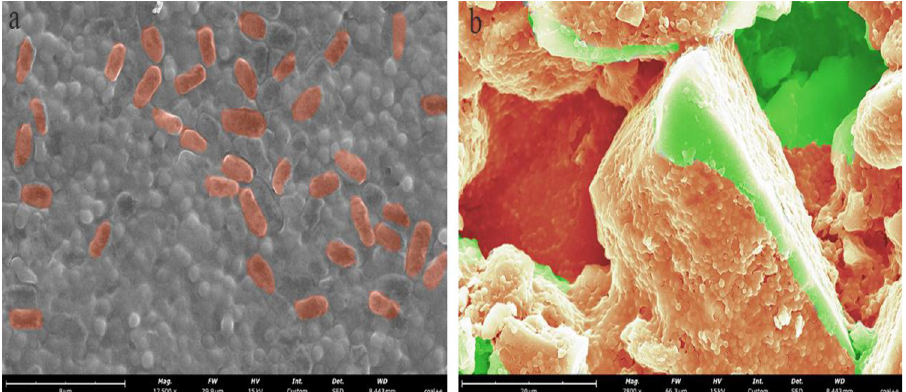
Fig 3. Scanning electron micrograph showing (a) E . coli cells and (b) coal interaction with E . coli .